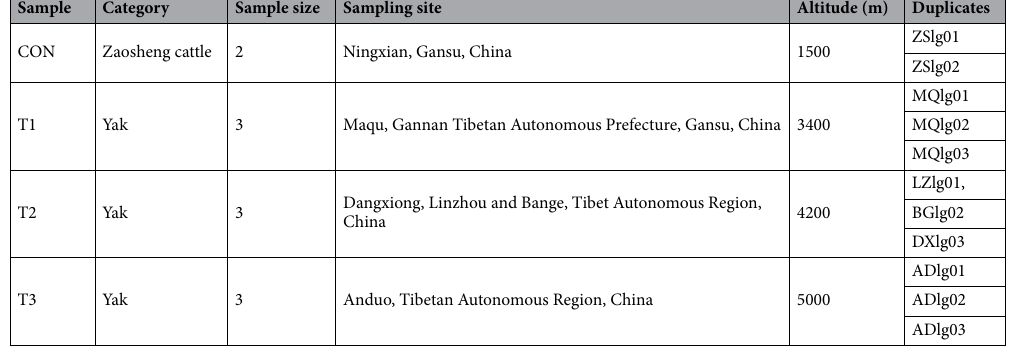
Table 2. Characteristics of samples.